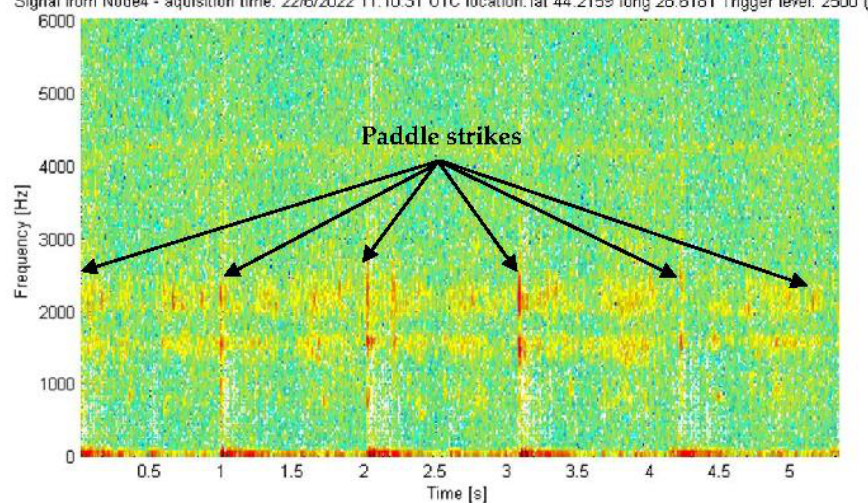
Figure 34. Signal picked up by a beacon in the presence of a paddle boat.